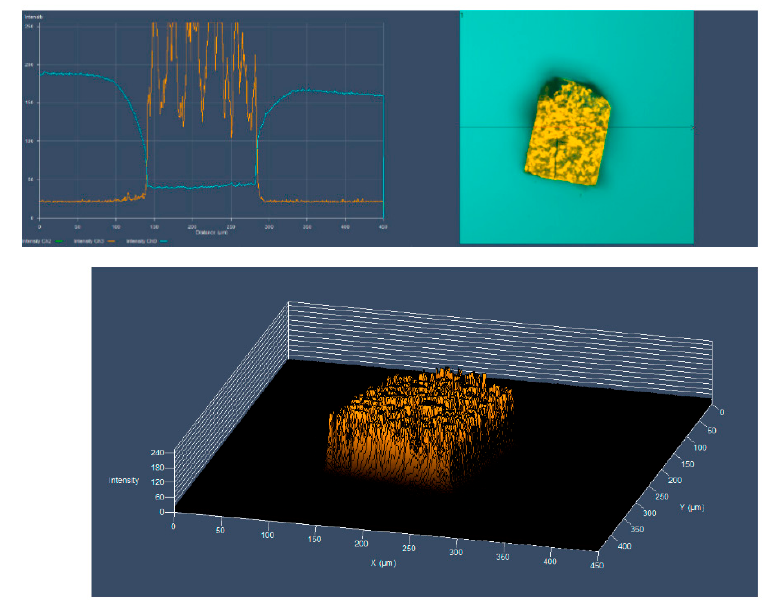
Figure 6. Representative CLSM image of L-Cys / Au(I)@CD-MOF. ( Upper right ) An optical image of L-Cys / Au(I)@CD-MOF ( upper left ), the one-dimensional of fluorescence intensity, and ( bottom ) a 3D reconstruction.